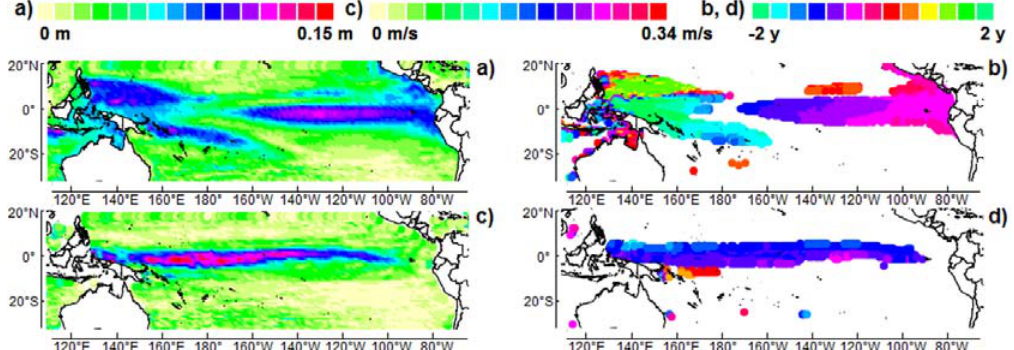
Figure 2 . Amplitude (left) and phase relative to November 1997 (right) averaged in the broadband 1.5–7 years of ( a , b ) antinodes, ( c , d ) zonal velocity u (facing east) at the nodes; –SOI (the opposite of SOI) is used as the reference signal so that the phase is expressed relative to the maximum of –SOI, that is, the maturation phase of El Niño in November 1997. The monthly Southern Oscillation Index (SOI) is provided by the National Center for Atmospheric Research: www.cgd.ucar.edu/cas/catalog/climind/soi.html.